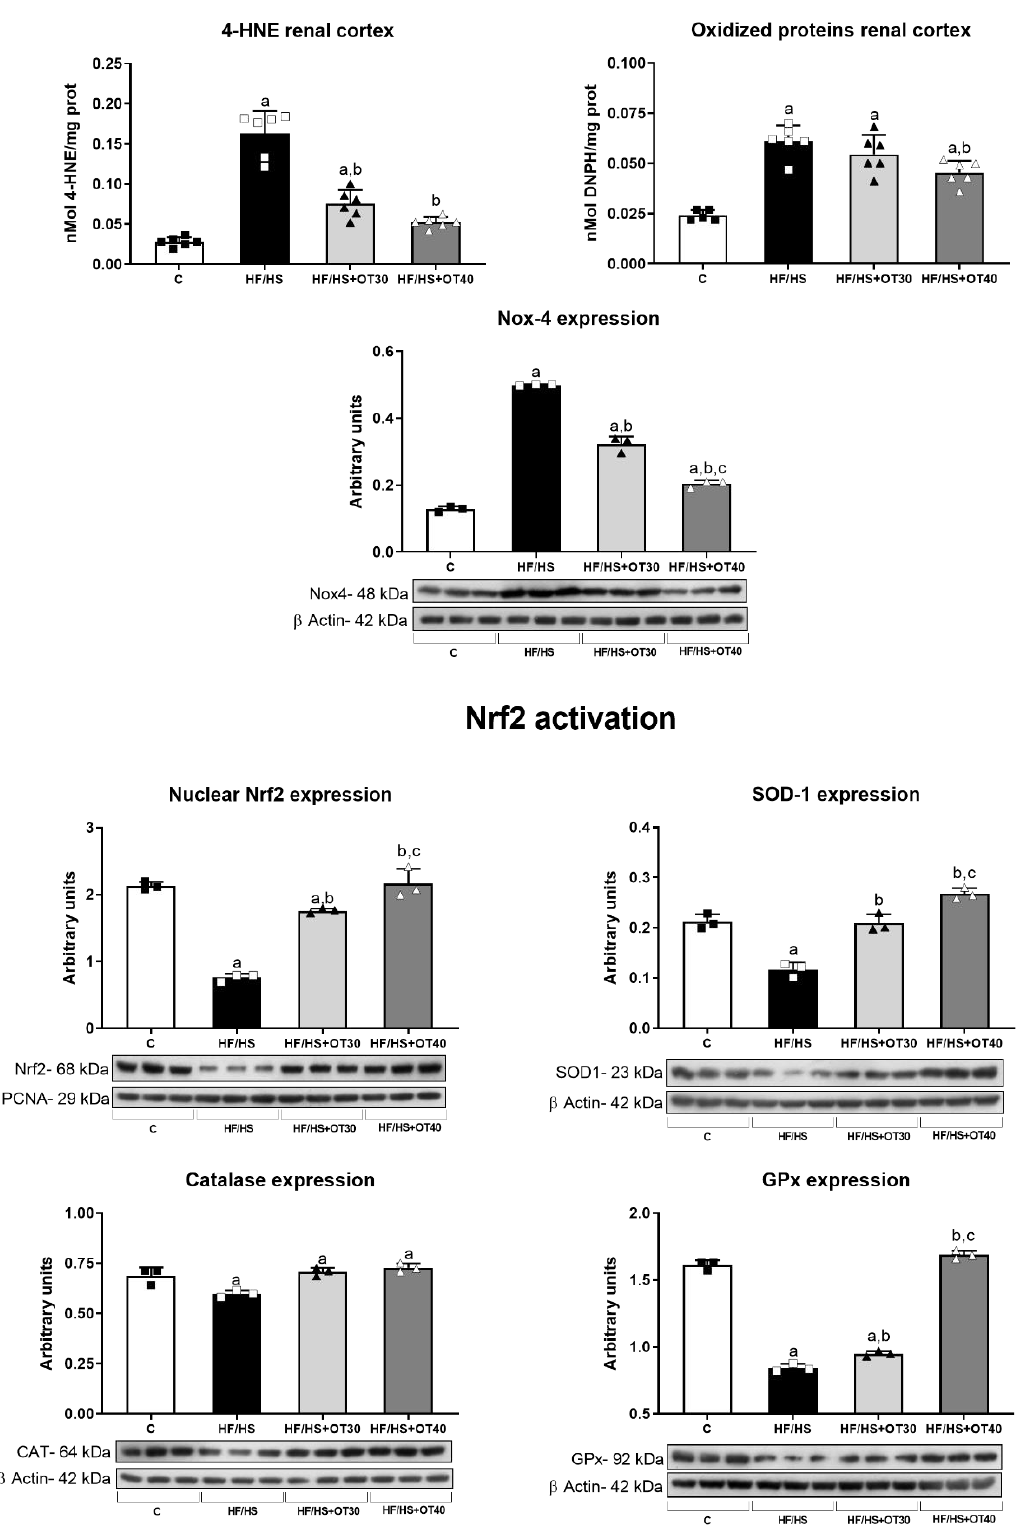
Figure 6. Oxidative stress. Shown are measurements of lipid peroxidation (4-hydroxynonenal (4-HNE)), protein carbonylation, and levels of expression of Nox-4, nuclear factor erythroid 2-related factor (Nrf2), and antioxidant enzymes (SOD-1, CAT, and GPx) in the renal cortex. For Western blotting, 3 randomly selected samples per group were analyzed. Results are presented as the mean ± SD and analyzed by one-way ANOVA. Post hoc analysis was performed using Bonferroni’s test. a: p < 0.05 vs. C; b: p < 0.05 vs. HF/HS; c: p < 0.05 vs. HF/HS + OT30.